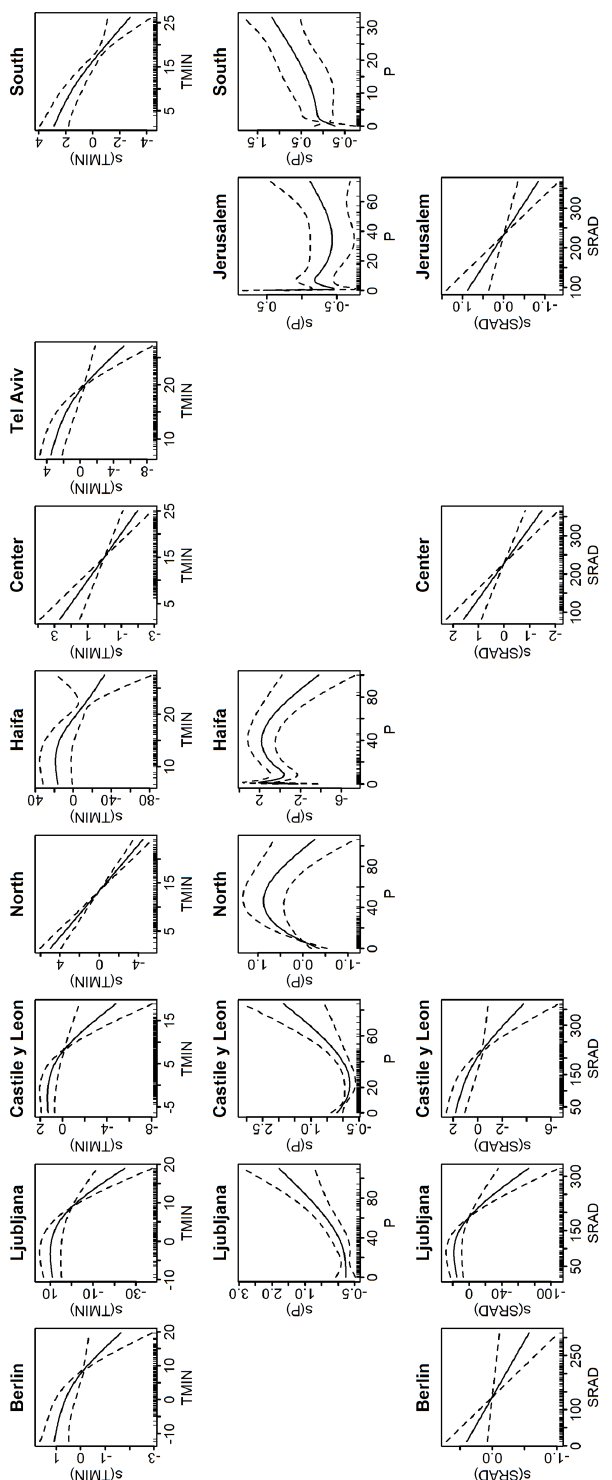
Fig 5. Plots of the meteorological smooth terms for Model 2 (with minimum temperature). Only terms that are significant are plotted. The y-axis is in the predictor scale (log(y)) and normalized, while the x-axis is the value of the meteorological variable. The dashed lines are the 95% confidence interval. Downward slope indicates inverse relationship, while upward slope indicates proportional relationship.